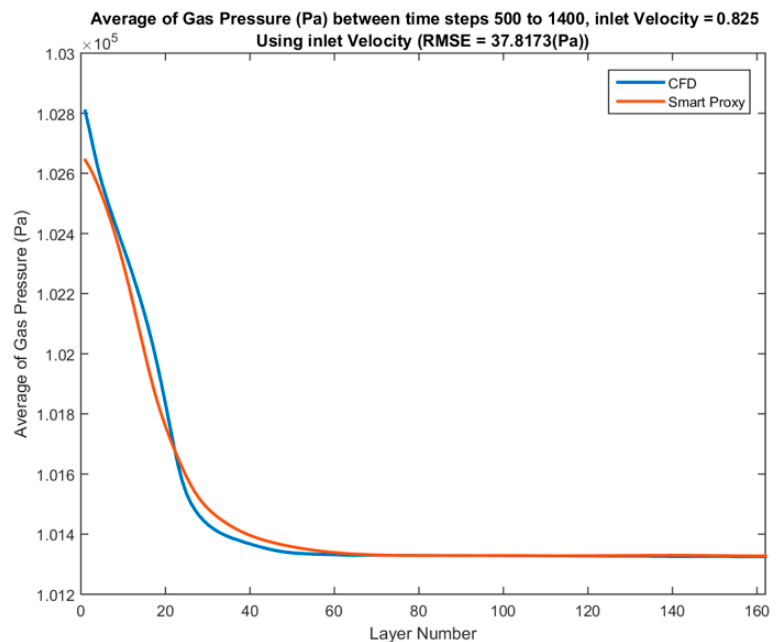
Figure 46. Spatial average profile of CFD and smart proxy results for gas pressure (Pa), averaged over time steps 500 to 1400 at blind test condition of V in = 0.825 m/s.